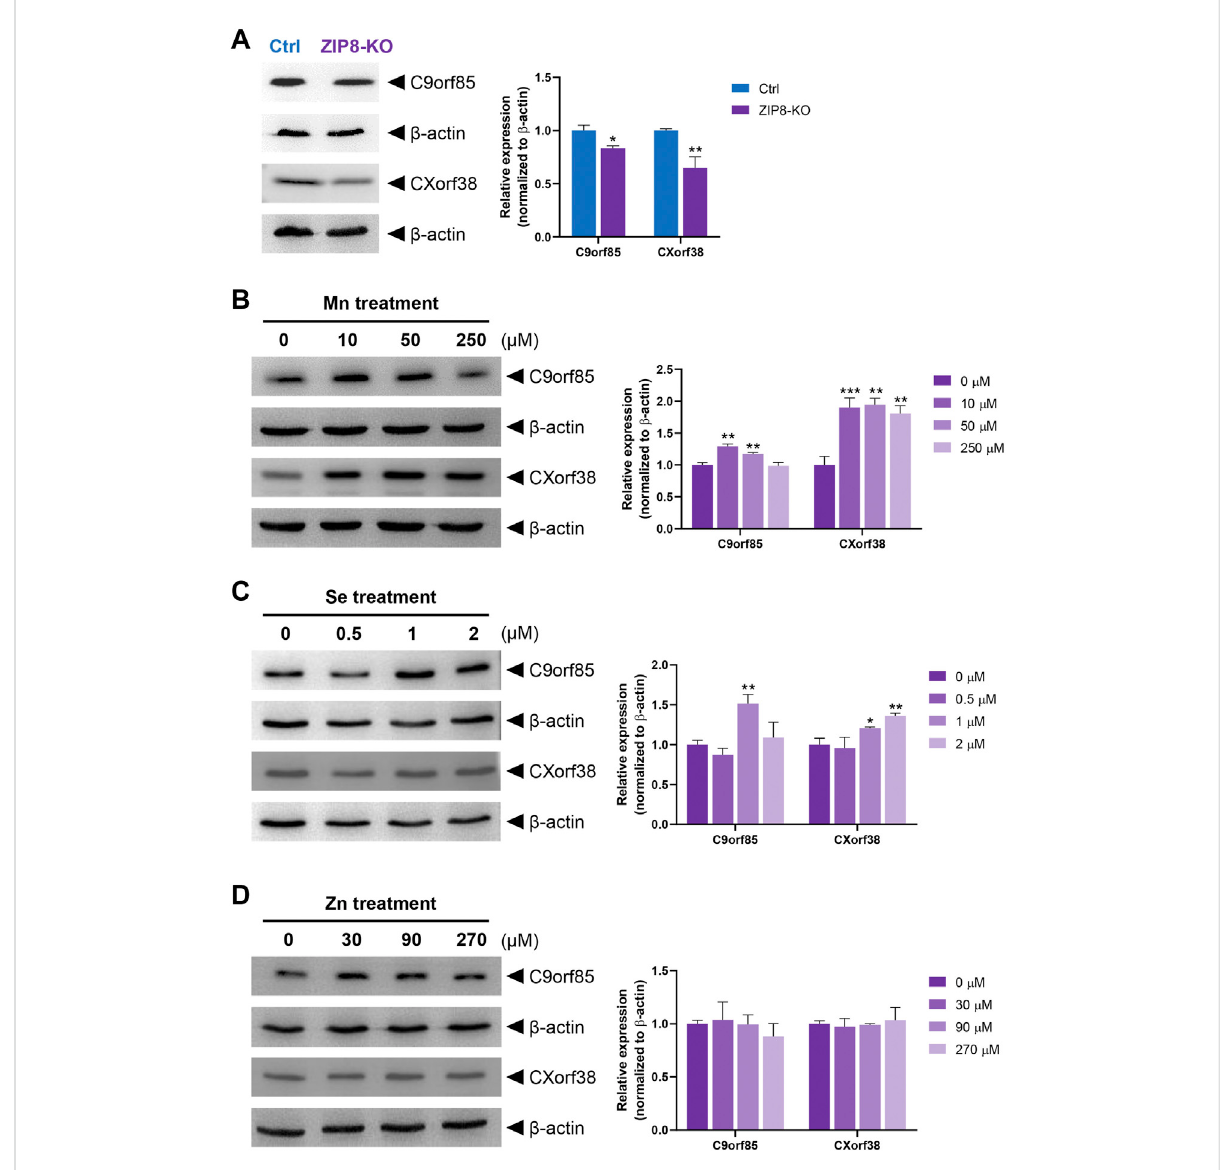
FIGURE 5 ImmunoblotanalysisofuncharacterizedhumanproteinsC9orf85andCXorf38treatedwithessentialmicronutrients(seeSupplementaryFigure S4forfullblotimages). (A) ProteinlevelsofC9orf85andCXorf38inHeLaparentalcells(withWTZIP8)andZIP8-KOHeLacells. (B – D) Proteinlevelsof C9orf85andCXorf38inZIP8-KOHeLacellsexposedtovariousconcentrationsofessentialmicronutrientsMn (B) ,Se (C) ,andZn (D) for24 h.Images are representative of independent experiments with similar expression trends of at least three independent experiments, and error bars represent mean ± SD of triplicate samples. * p ≤ 0.05; ** p ≤ 0.01; *** p ≤